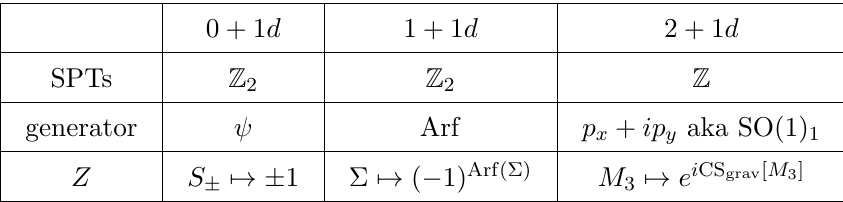
Table 1 . The first row gives the classification of SPT phases with no symmetries, the second the generators of the SPT classes, and the last the partition functions of the generators. S a circle with periodic/antiperiodic (R / NS) boundary conditions; Σ is a compact Riemann surface, and Arf(Σ) is the Arf-invariant of the surface with spin structure, which evaluates to 0 on even and to 1 on odd spin structures; and M